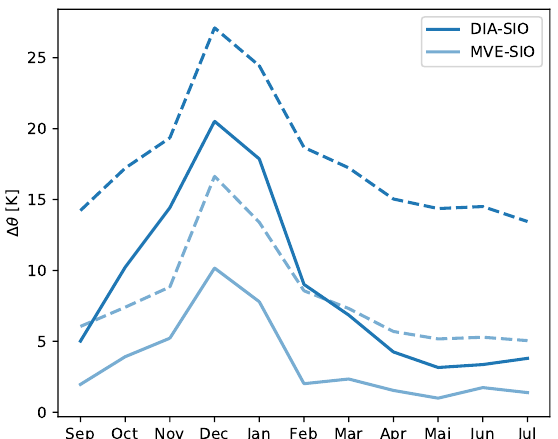
Figure 12. Annual cycle of minimum daytime (sold lines) and maximum nighttime (dashed lines) mean stratification on valley wind days in the lower part of the valley atmosphere (MVE-SIO) and over the depth of the valley atmosphere (DIA-SIO). The stratification is indicated in terms of potential temperature differences between the three stations: Sion (SIO, 482m MSL), Montana (MVE, 1427m MSL), and Diablerets (DIA, 2964m